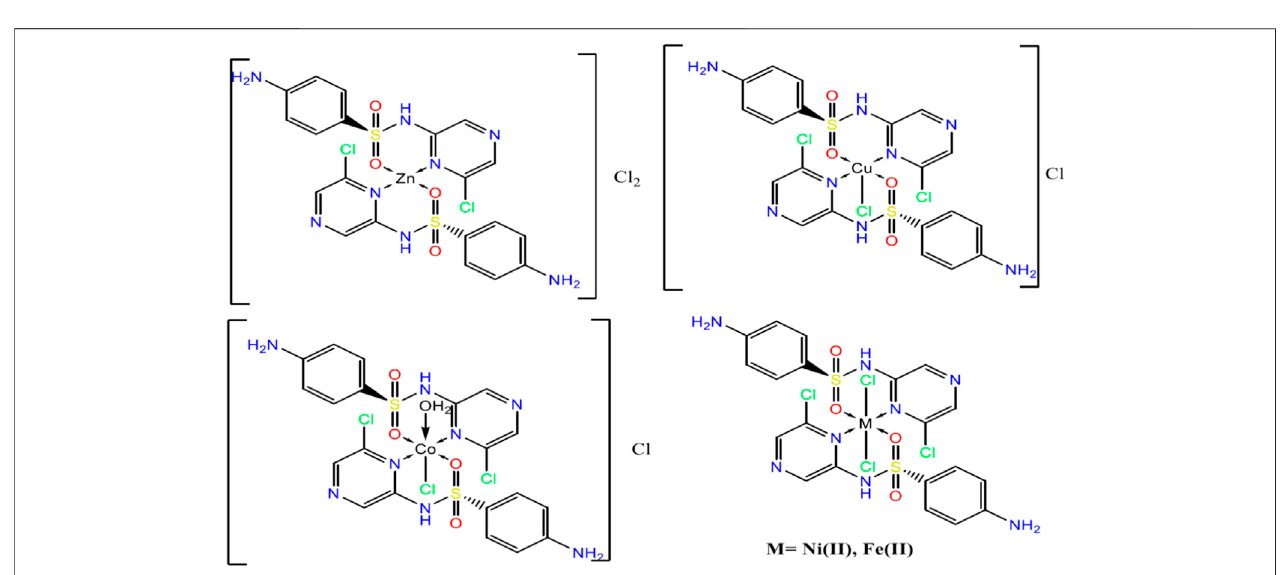
FIGURE 4 | The suggested structures of the SCZ metal